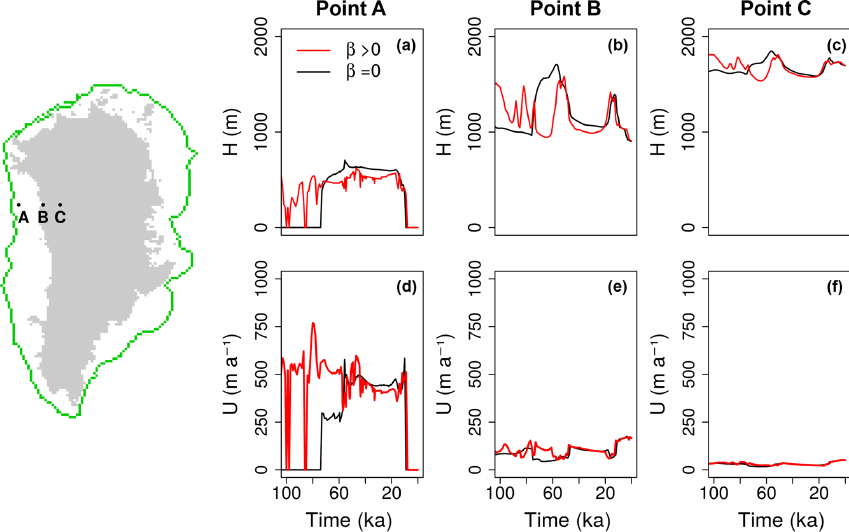
Figure 6. Transient dynamics specified for three locations along Baffin Bay. Ice thickness (a, b, c) and velocity (d, e, f) LGP evolution is shown for the glacial marine margin (point A), present-day marine margin (point B) and far in the interior of the ice sheet (point C). Black curves indicate the dynamics of the ORB max simulation, red curves represent the dynamics of the TOT max simulation. The green line on the map on the left-hand side shows the maximum GrIS glacial extent simulated in TOT max